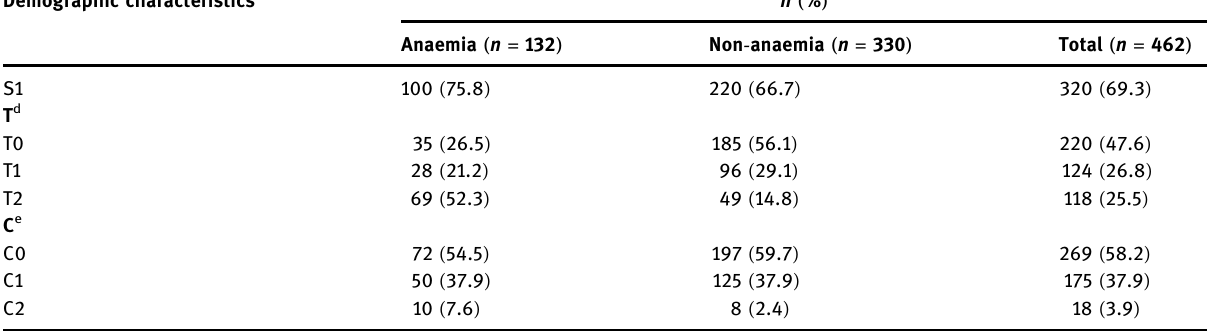
Figure 4b. DCA showed that the net bene fi t rate was > 0 at a high - risk threshold between 1 and 84%, which was clinically signi fi cant, and that the smaller the threshold was between 1 and 84%, the higher the net bene fi t rate.